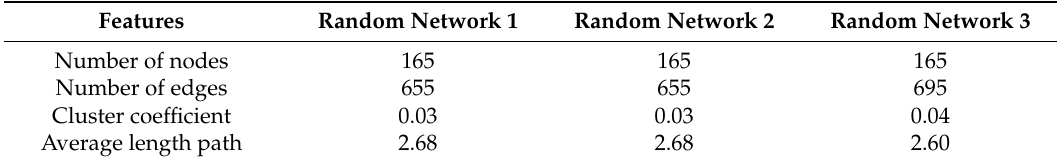
Table 5. Statistical features of three random networks.